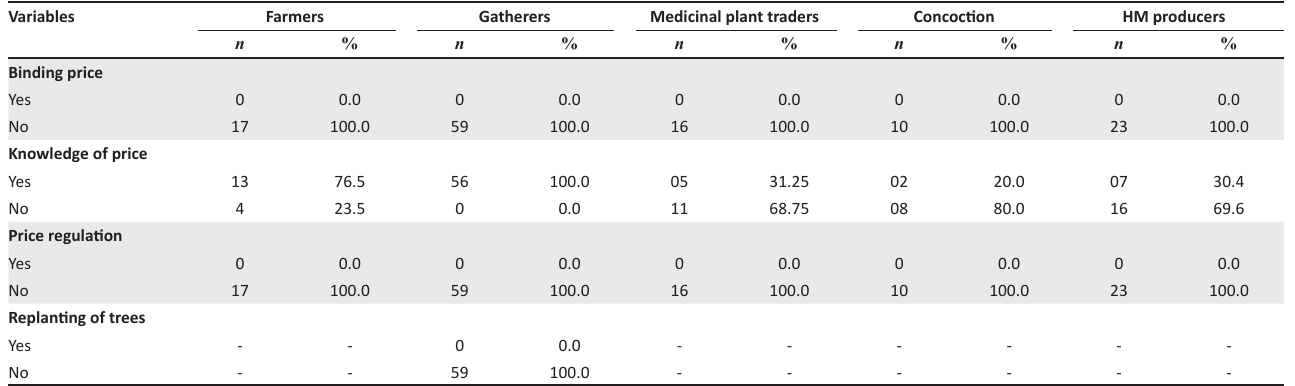
TABLE 7: Conduct of the supply